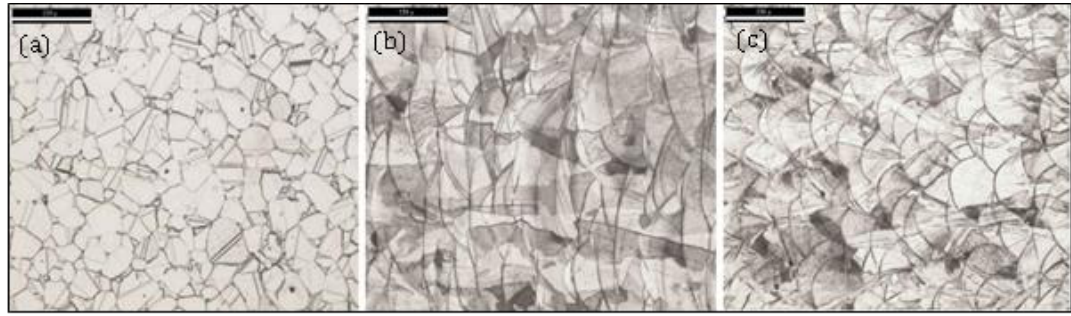
Figure 3. Optical microscopy images of 316L samples in etched condition (Glyceregia etchant): ( a ) BJ 50x; ( b ) EBM 50x; ( c ) DMLS 50x. Scale bars are 150 µm [70].